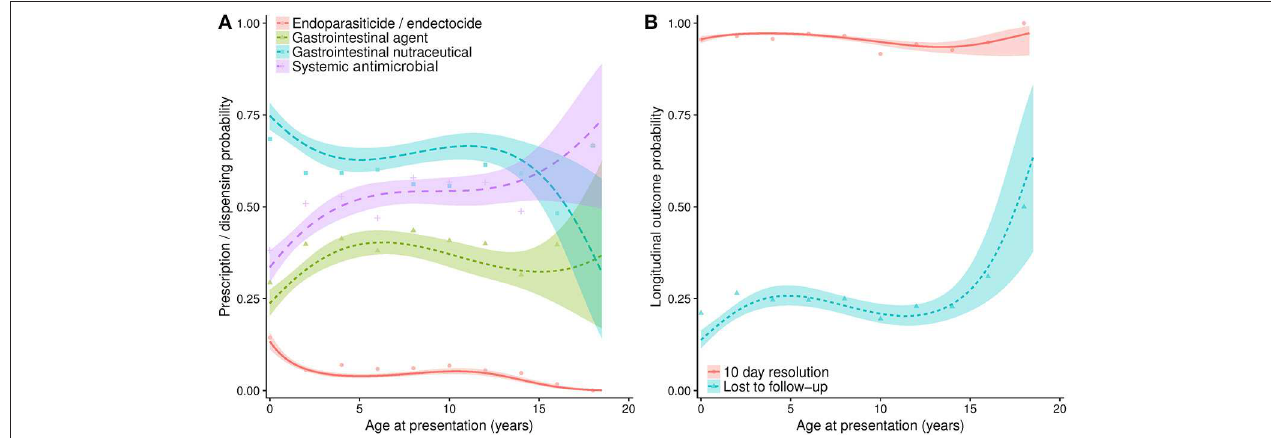
FIGURE 2 | (A) Projections from a series of multivariable logistic regression models, estimating the probability of a range of pharmaceutical agents being prescribed at initial presentation for diarrhoea, when considered against age at presentation (in years). (B) Estimates of longitudinal outcome, including probability of a case being lost to follow-up or being considered resolved of diarrhoeic clinical signs 10 days post-initial presentation. Lines refer to predicted probability, with shading relating to 95% confidence intervals to such predictions. Points are plotted to show original data points expressing the percentage of animals of each relevant age group (rounded to 2 year groups) that were prescribed a pharmaceutical agent, or were classified into the resolved or lost to follow-up